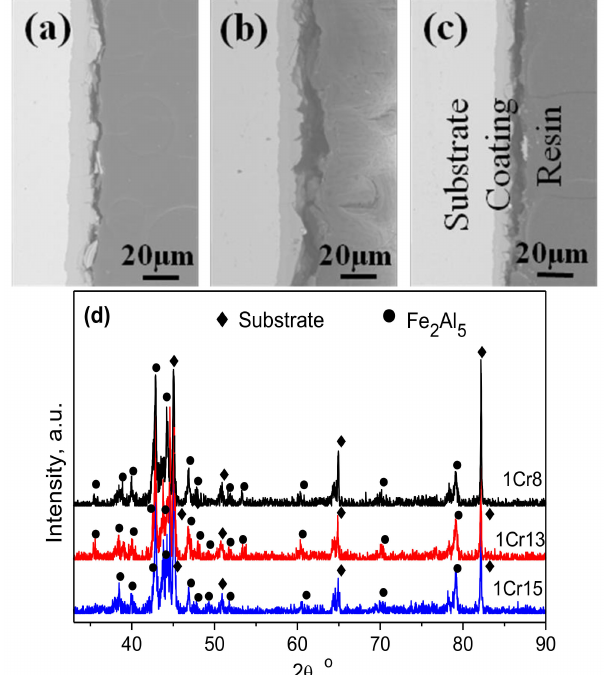
Figure 4. Cross-section images of aluminide coatings formed on Al deposited ( a ) 1Cr8, ( b ) 1Cr13, and ( c ) 1Cr15 steel substrates and ( d ) the corresponding XRD patterns after 500 ◦ C, 4 h heat treatment in